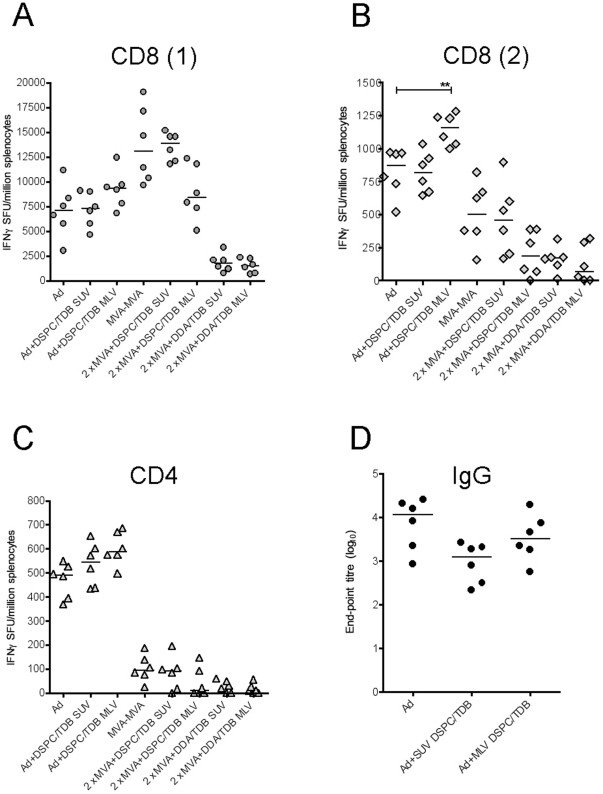
Cellular and humoral responses to liposome-adjuvanted viral vectored vaccines.T cell and antibody responses were assessed in Balb/c mice at peak time-points for Adenovirus (Ad) and Modified Vaccinia Ankara (MVA) viral vectored vaccines expressing TIPeGFP, i.e. two weeks after a single injection of Ad and one week after two injections of MVA, combined with cationic DDA:TDB or neutral DSPC/TDB liposomes. Spleen T cell responses to two CD8 (A, B) and one CD4 epitope (C), contained within the insert of the viral constructs, were measured using IFNγ ELISpot. D) Total IgG titre in the serum of mice immunised with the Ad+liposome formulations at the peak time-point. **p<0.01.